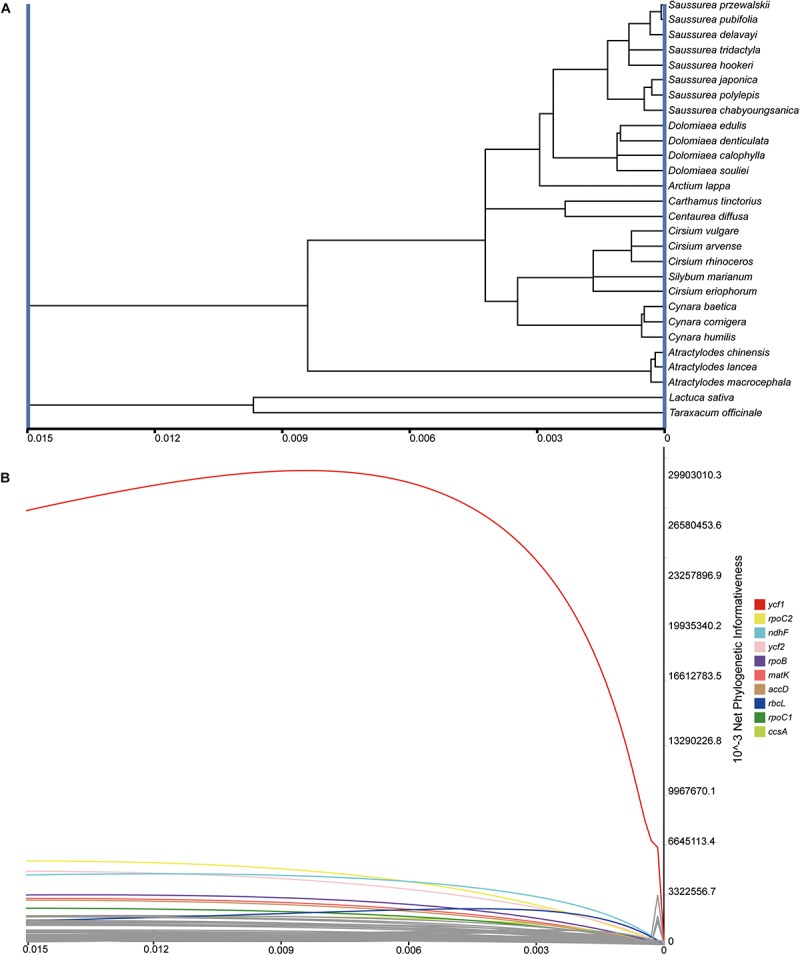
Phylogenetic net informativeness profiles of 79 PCGs of Cardueae estimated in PhyDesign (Lopez-Giraldez and Townsend, 2011). (A) The ultramteric tree of Cardueae converted in the dnamlk program in PHYLIP (Felsenstein, 1989). (B) Net phylogenetic informativeness profiles for 79 PCGs. Ten genes with the greatest informativeness are color-coded and indicated at the right. X- and Y-axes represent relative-time and net phylogenetic informativeness, respectively.